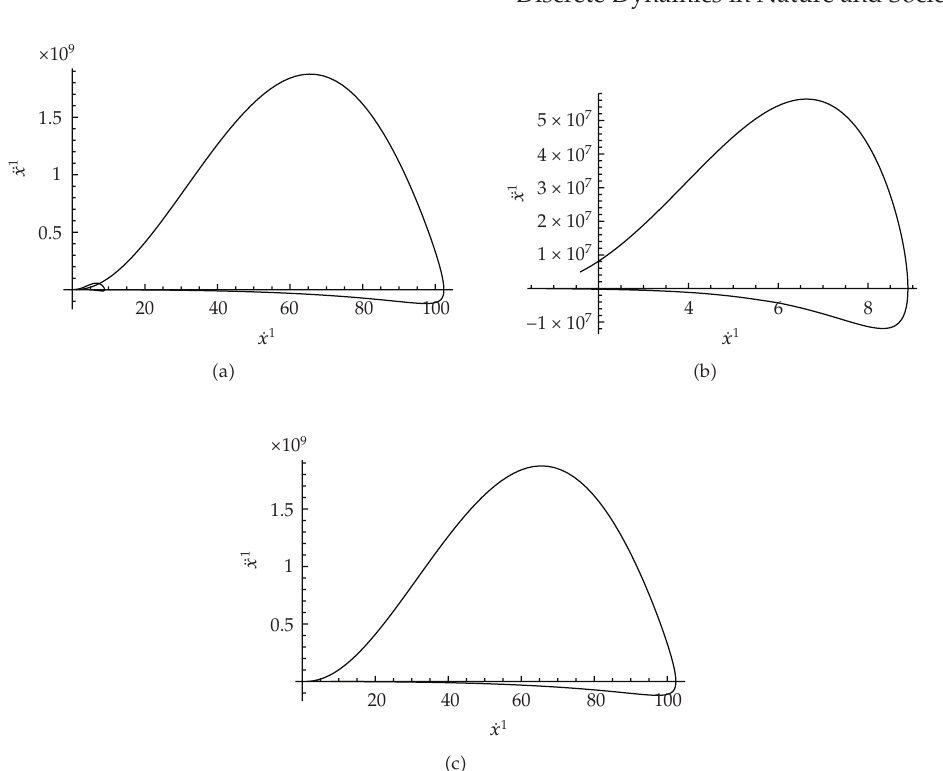
Figure 8: See also Figure 9. Figures 8 (cid:6) a (cid:7) and 9 (cid:6) a (cid:7) a two-loop-cycle orbit, as shown in ˙ x 1 , ¨ x 1 graph (cid:6) Figure 8 (cid:6) a (cid:7)(cid:7) and ε, ˙ ε graph (cid:6) Figure 9 (cid:6) a (cid:7)(cid:7) . Initial conditions: ˙ x 0 (cid:3) 0 . 8, ˙ x 1 (cid:3) 0 . 1, ˙ x 2 (cid:3) 0 . 1, ˙ x 3 (cid:3) 0 . 1, ¨ x 0 (cid:3) − 10000, ¨ x 1 (cid:3) 4, ¨ x 2 (cid:3) 5, ¨ x 3 (cid:3) 7, M/α (cid:3) 4 . 8 · 10 7 GeV 2 , and μ (cid:3) 10 − 5 GeV − 1 . Figures 8 (cid:6) b (cid:7) and 9 (cid:6) b (cid:7) . The first loop cycle. ε has relatively low value (cid:6) Figure 9 (cid:6) b (cid:7)(cid:7) when the value of ˙ x 1 is relatively high (cid:6) Figure 8 (cid:6) b (cid:7)(cid:7) . Figures 8 (cid:6) c (cid:7) and 9 (cid:6) c (cid:7) . The second loop cycle, smaller than the first in the ε, ˙ ε graph and larger than the first in the ˙ x 1 , ¨ x 1